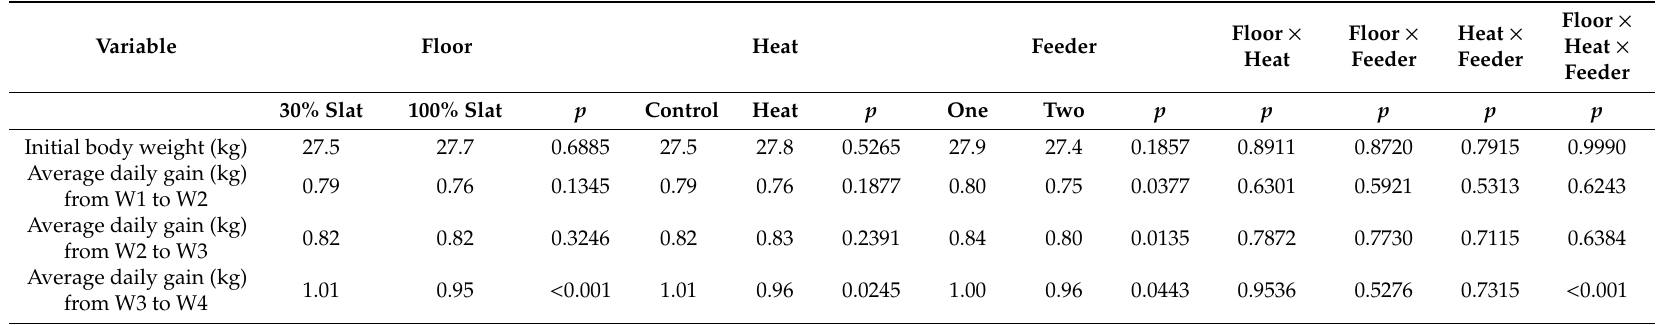
Table 1. Results of the statistical analysis ( p = p -value) on the initial body weight (kg) and the average daily gain from this weight (W1) to one month later (W2), two months later (W3), and three months later (W4), and where floor is related to the type of floor (30% slat 70% concrete vs. 100% slat), heat to the e ff ect of temperature (heat room vs. control room), and feeder to the number of feeders per pen (one: single; two: double), and all the possible double (floorxheat, floorxfeeder, and heatxfeeder) and triple (floorxheatxfeeder) interactions.